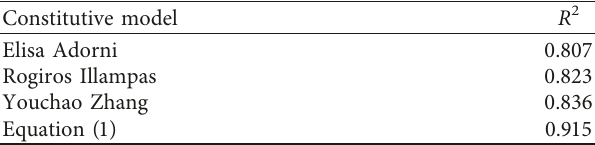
Table 4: R 2 of different constitutive modes. Constitutive